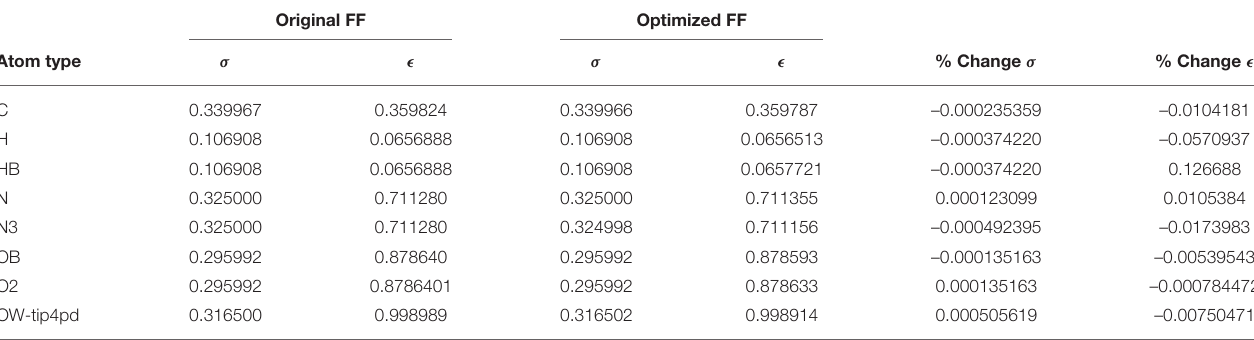
TABLE 2 | Original and optimized Lennard-Jones parameters for RS-peptide.